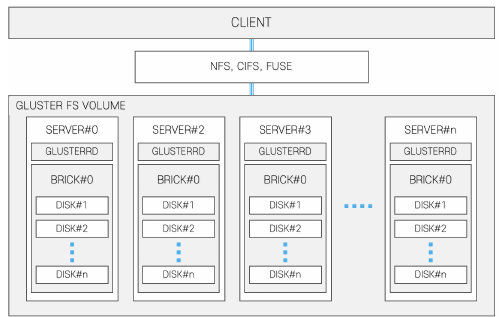
Figure 3. Structure of GlusterFS.